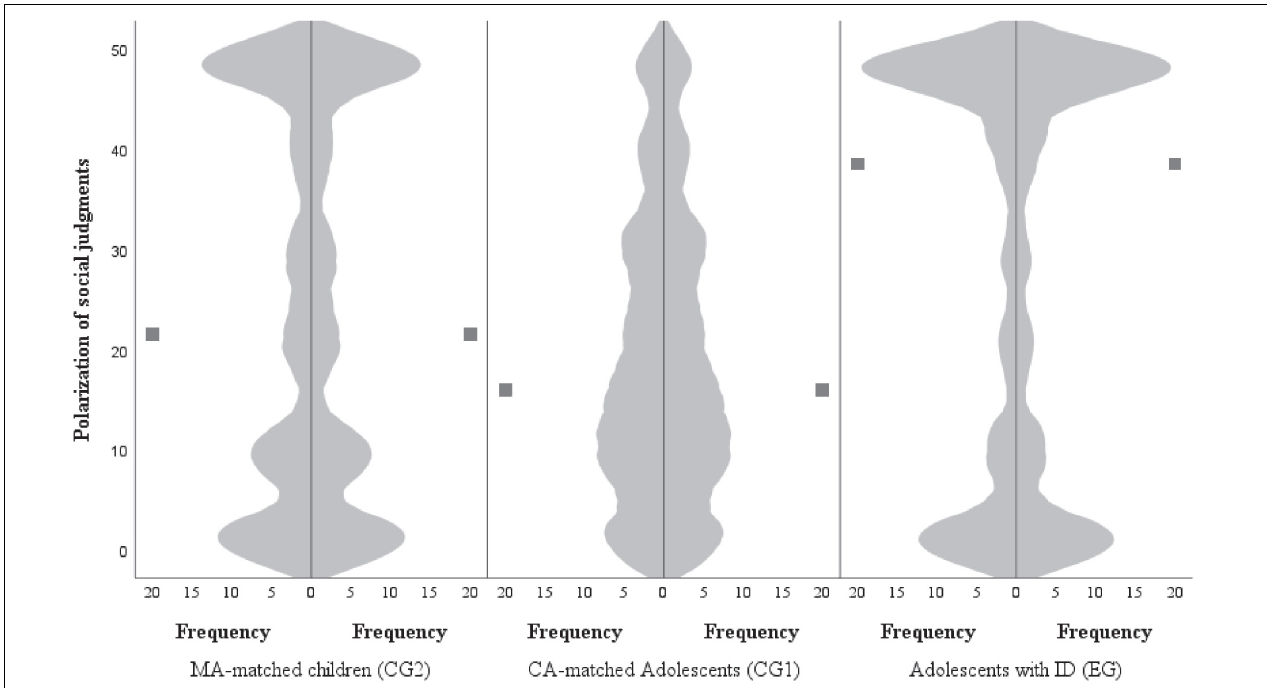
FIGURE 2 | Polarization of social judgments within the three groups. Values close to 0 = ratings close to the center of the scale, values close to 50 = ratings close to the outer poles of the scale. Squares represent the medians. EG, experimental group comprising adolescents with intellectual disability (ID); CG1, comparison group 1 comprising chronological age-matched adolescents without ID; CG2, comparison group 2 comprising mental age-matched